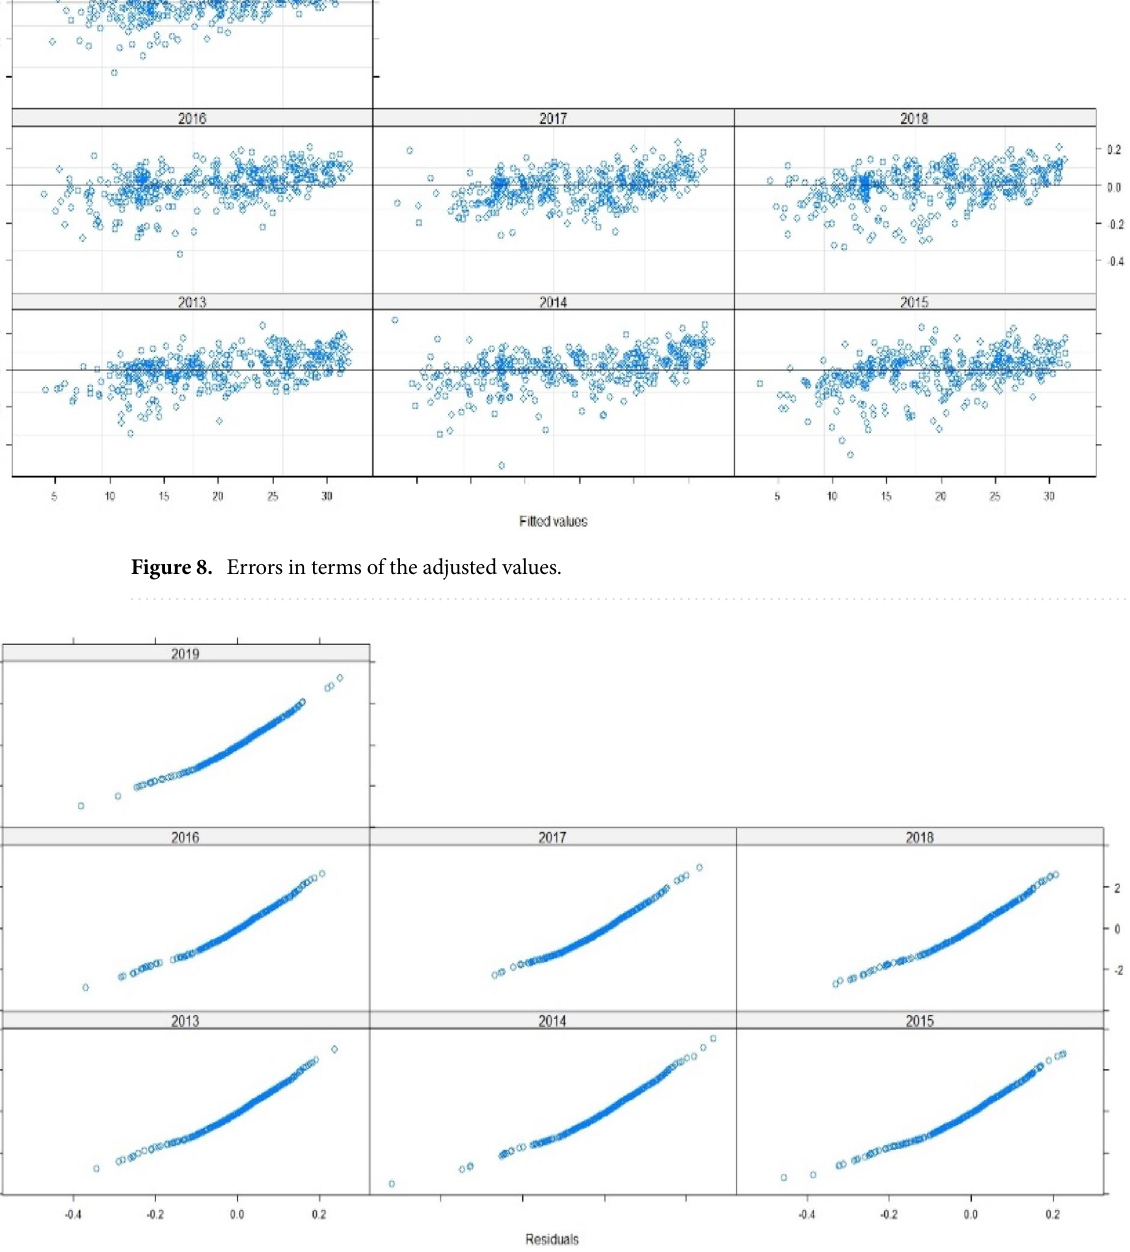
Figure 9. The standard